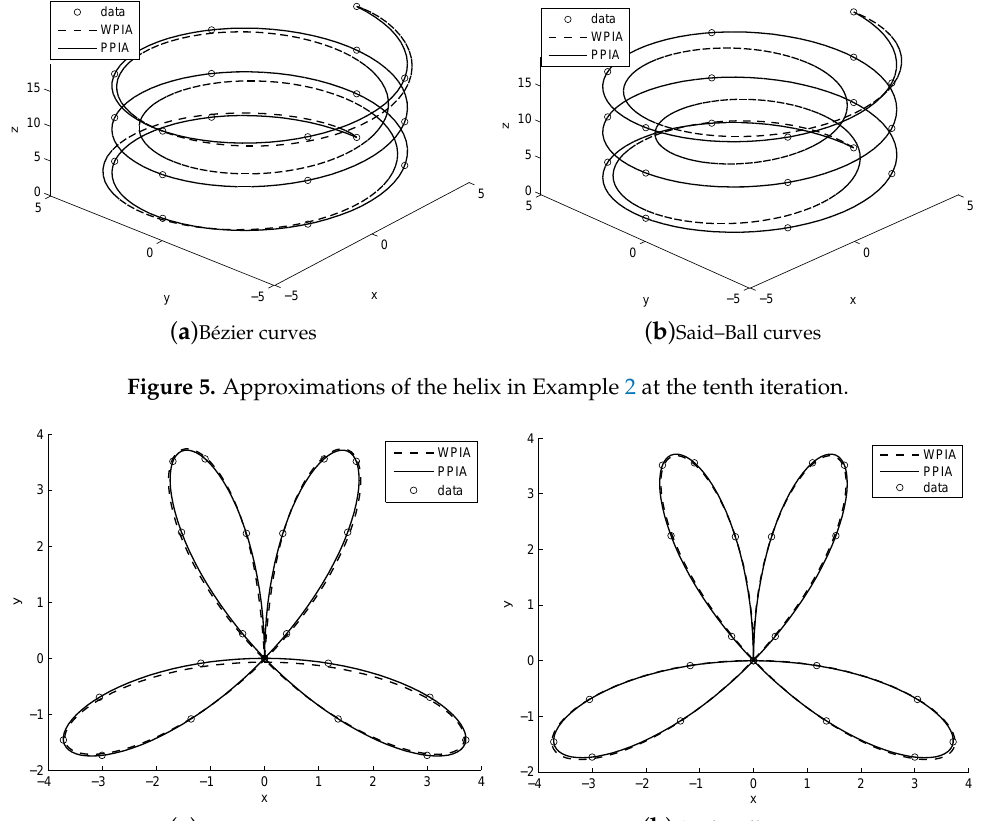
Figure 6. Approximations of the four-leaf clover in Example 3 at the tenth